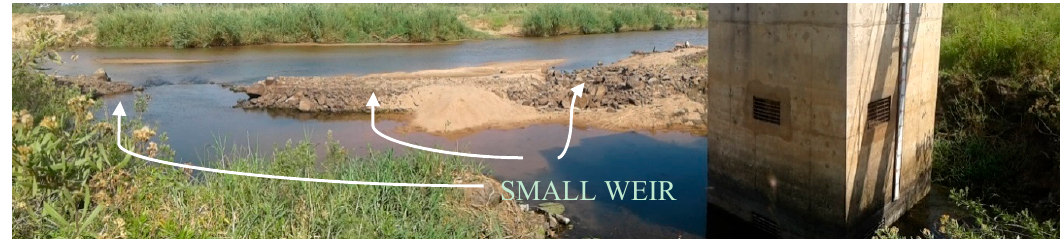
Figure 5. Picture of small weir next to the intake structure (Silva ‐ Novoa. 24 January 2018).